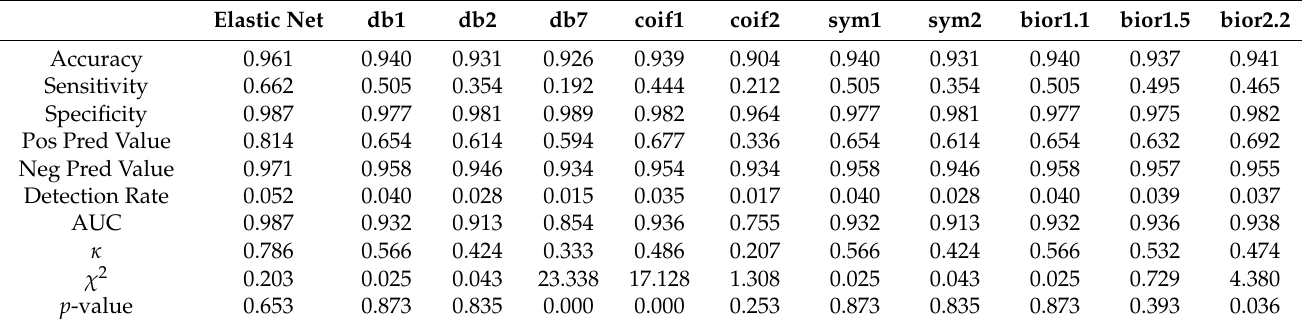
Table 3. Summary of reconstruction of pattern presented in Figure Table 2. Summary of reconstruction of pattern presented in Figure 8.